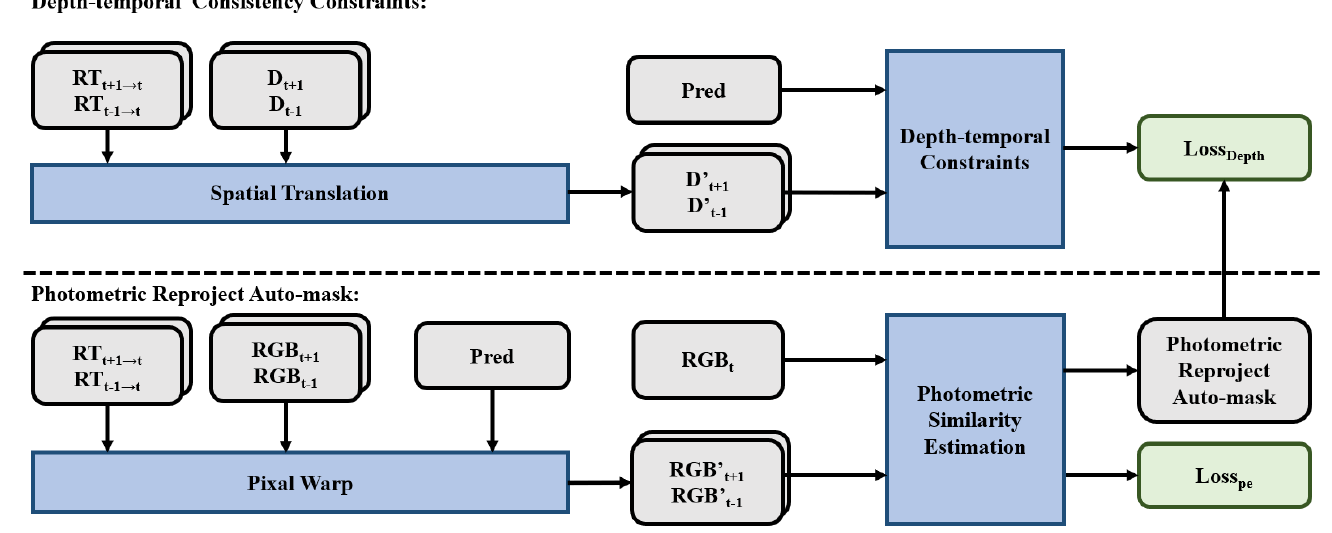
Figure 2. Multi − modal spatio − temporal consistency